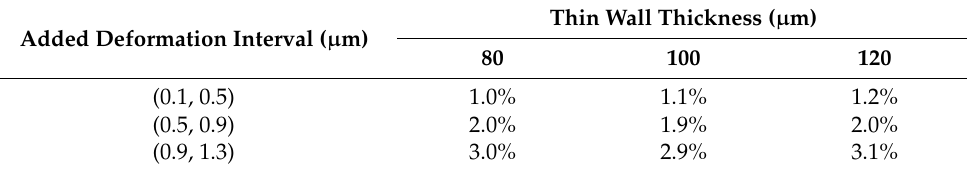
Table 10. Thin wall relative dimensional